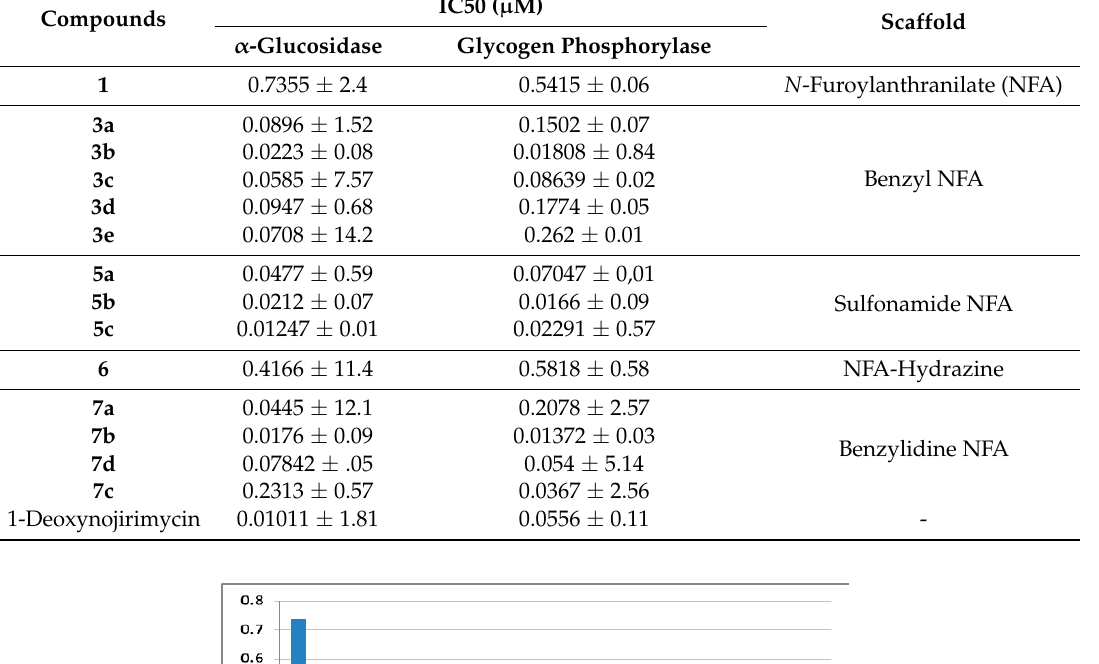
Table 1. Inhibitory data of the target compounds to both α -glucosidase and glycogen phosphorylase.